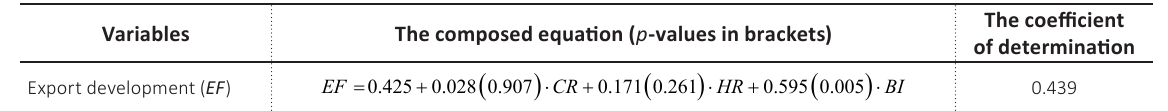
Table 4. The impact of cooperative relationships, infrastructure of business and human resources on export